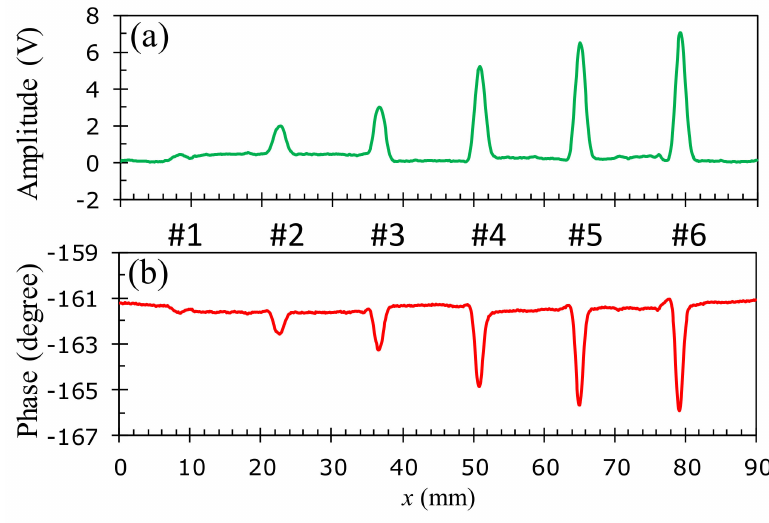
Figure 17. Inspection of cracks buried at h = 0.095 mm at the 40 kHz optimal excitation frequency on an aluminum specimen: ( a ) amplitude variation, ( b ) phase angle variation.